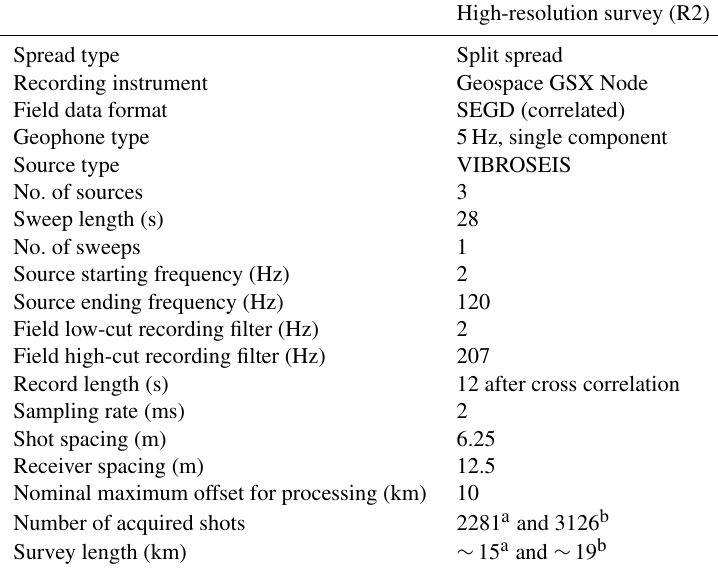
High-resolution survey